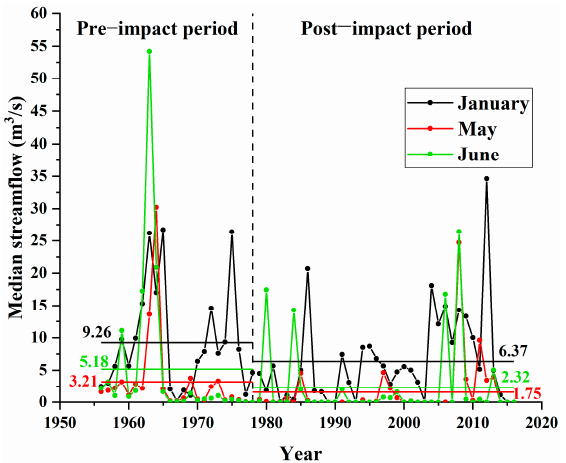
Figure 9. Median streamflow for January, May, and June.